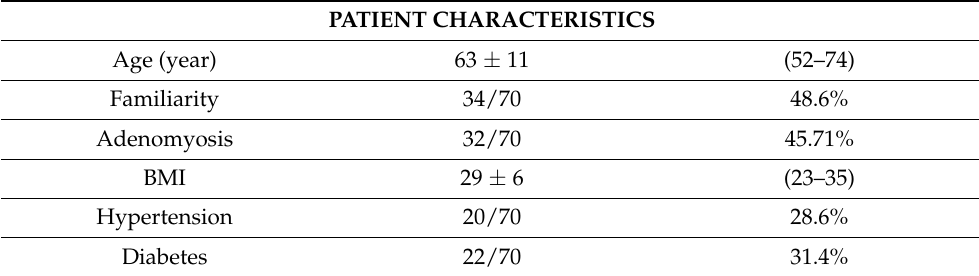
Table 3. Clinical presentation of 70 patients with endometrial